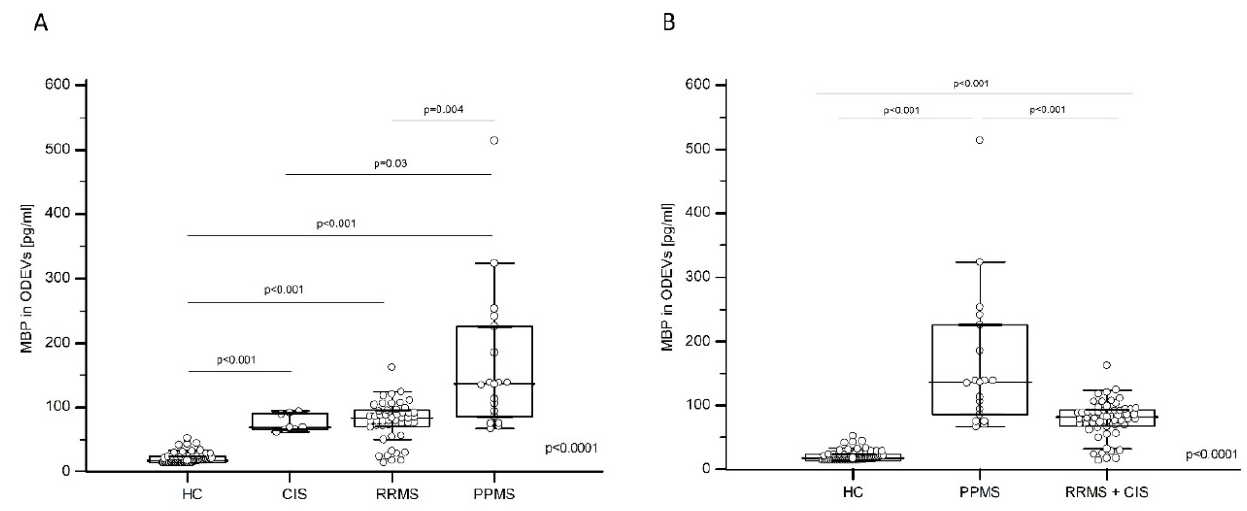
Figure 2. MBP in enriched ODEVs in HC, CIS, RR-MS, and PP-MS. ( A ): Multiple comparison graphs of MBP concentration in enriched ODEVs, respectively in HC, CIS, RRMS, and PPMS subjects; all data are plotted, and median and interquartile range (IQR) are reported. The reported global p values of the differences between the groups of subjects was calculated by Kruskal–Wallis test for non-parametric distributions. p values of post hoc Dwass–Steel–Critchlow–Fligner for pairwise comparisons are also reported. ( B ): Multiple comparison graphs of MBP concentration in enriched ODEVs, respectively in HC, (CIS + RRMS) and PP-MS subjects; all data are plotted; median and interquartile range (IQR) are reported. The reported global p values of the differences between the groups of subjects was calculated by Kruskal–Wallis test for non-parametric distributions. p values of post hoc Dwass–Steel–Critchlow–Fligner for pairwise comparisons are also